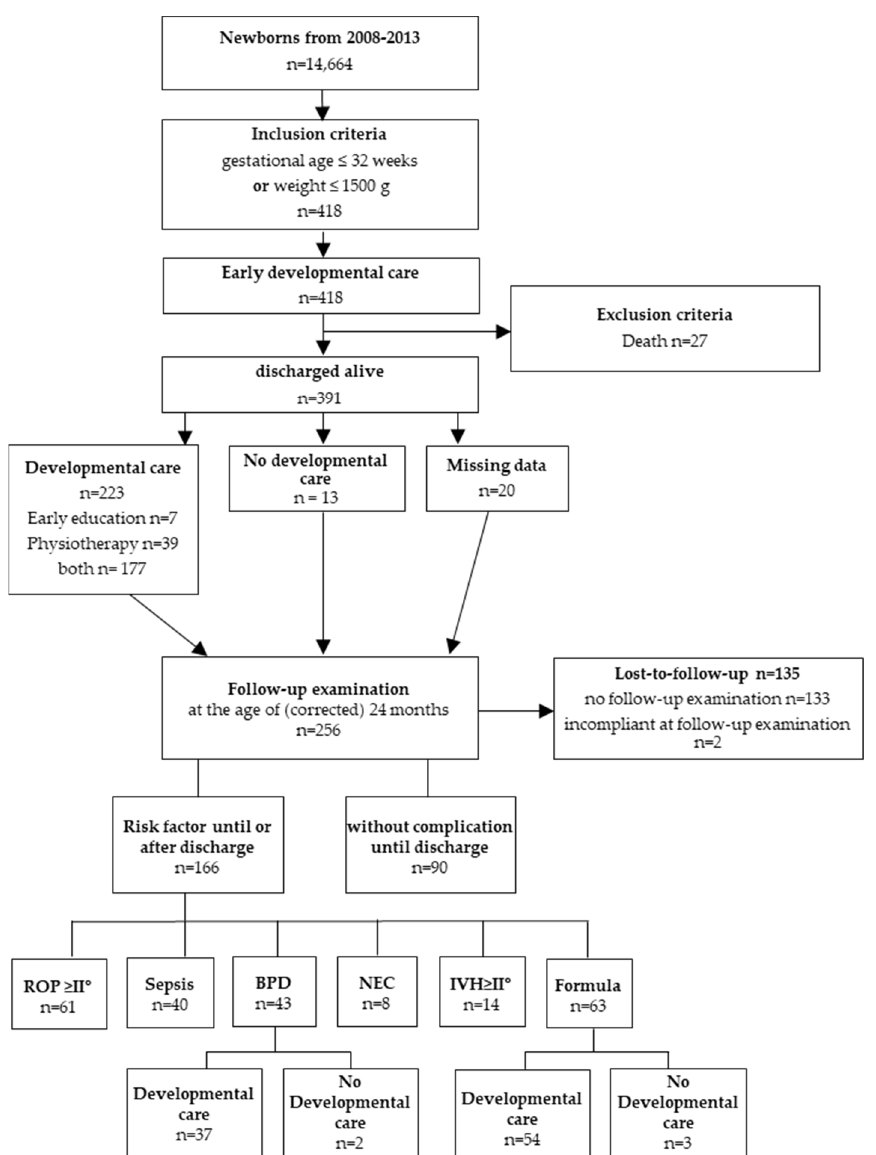
Figure 1. Study design. Overview of the inclusion and exclusion criteria of the study, developmental care, and follow-up examinations. Overall, 418 infants born ≤ 32 weeks and/or ≤ 1500 g were identified between 2008 and 2013. Twenty-seven infants met the exclusion criteria. All infants received early developmental care. Follow-up examinations were performed at the age of (corrected) 24 months. Two hundred fifty-six infants were examined, of which 166 showed risk factors until or after discharge from the hospital. Two hundred twenty-three children received developmental care after discharge until the age of 24 months. Abbreviations: n: number; BPD: bronchopulmonary dysplasia; IVH: intraventricular hemorrhage; NEC: necrotizing enterocolitis; ROP: retinopathy of prematurity. Table 1. Study population.